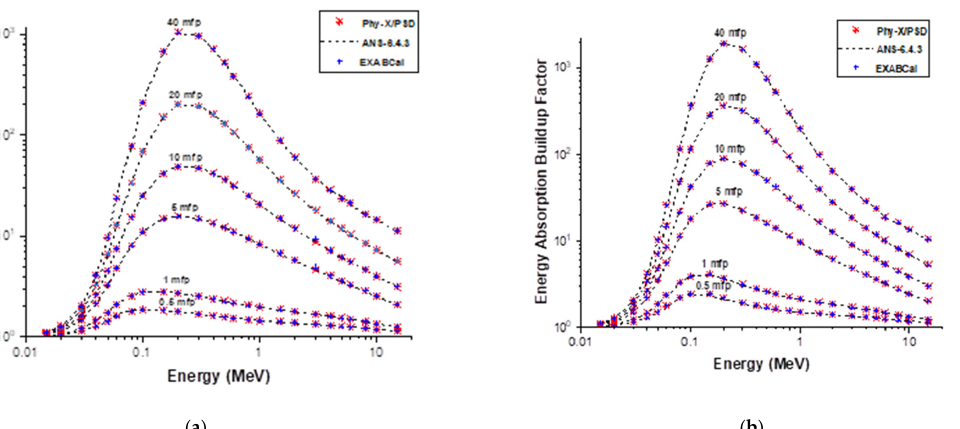
Figure 2. (a) EBF and ( b ) EABF of concrete obtained compared with those of the standard AN- SI/ANS-6.4.3 at different mfp’s. The EABF and EBF variations with the range of photon energy 0.015–15 MeV for each sample (A–H) at different penetration depths are shown in Figures 3 and 4, respec- tively. These results showed that the obtained value increased as the energy of the pho- ton increased for the discussed samples. For each sample, the increment continued until same trend with reports of other materials given by some researchers such as Singh and